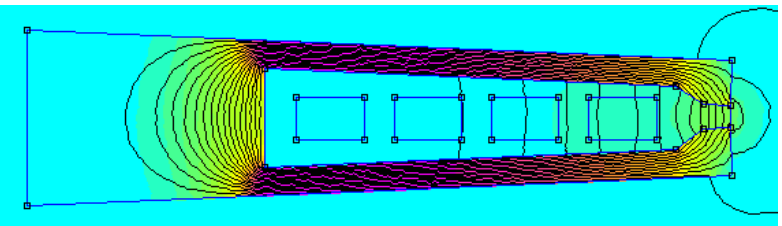
Figure 20. Polar shoes with the greatest depths.